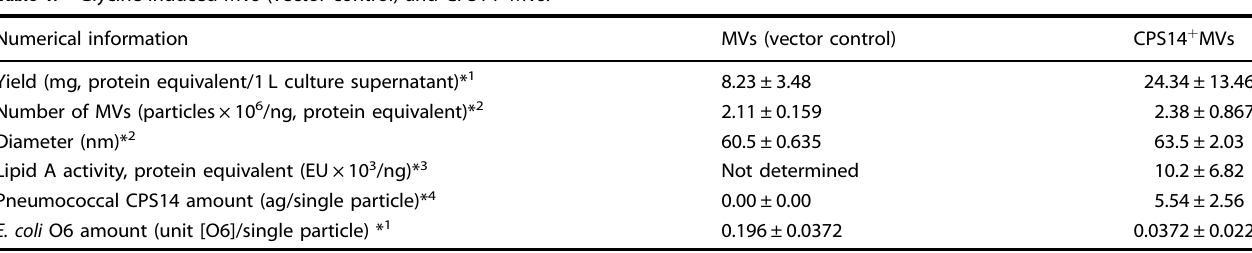
Table 1. Glycine-induced MVs (vector control) and CPS14 +